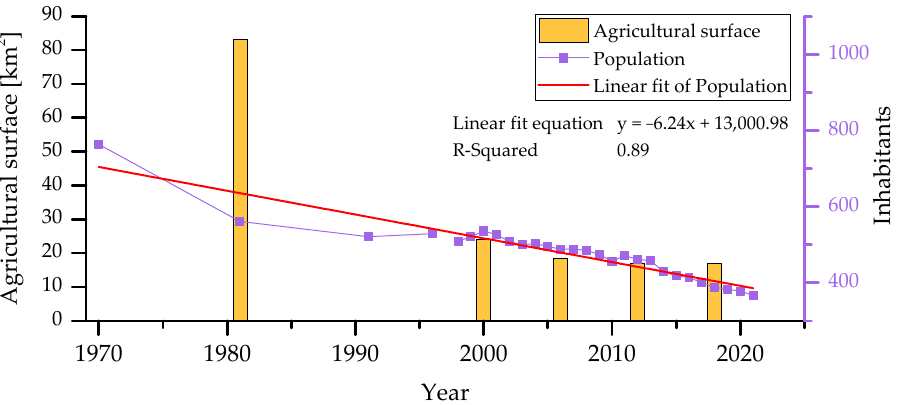
Figure 4. Land surface dedicated to agriculture on the Almudaina-Segaria aquifer, and evolution of the combined population of Vall d’Ebo and Vall d’Alcal à through the last 50 years. Both parameters show a downward trend since, in the area, depopulation of the originally rural settlements is associated to a decrease in the agricultural